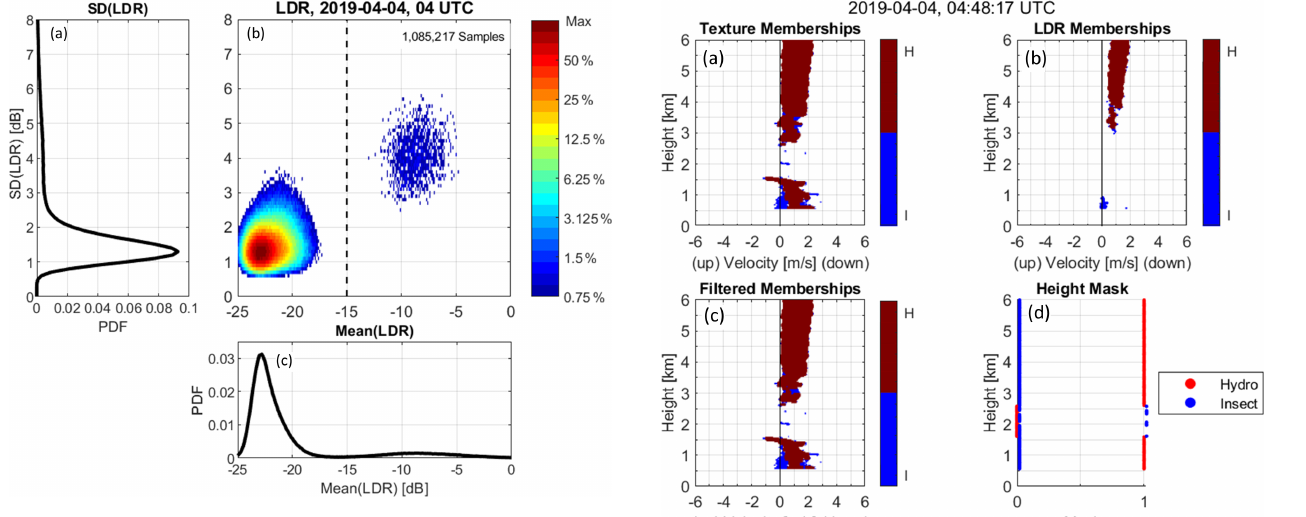
Figure 10. Similar to Fig. 7 except for hour 04:00UTC on 4 April 2019 and for SD(LDR) and mean(LDR) statistics. There are 1085217 samples collected below 1.5km height.